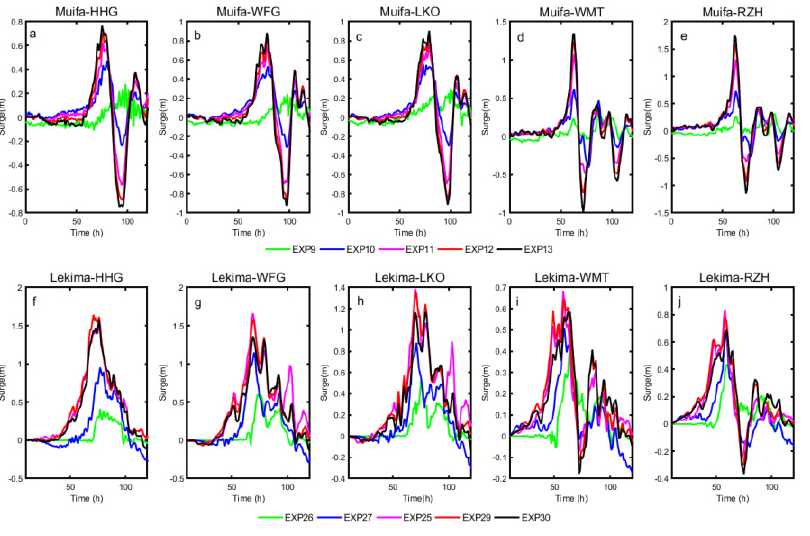
Figure 14. Storm surge associated with the RMW over time at ( a ) HHG, ( b ) WFG, ( c ) LKO, ( d ) WMT, and ( e ) RZH for Typhoon Muifa and ( f ) HHG, ( g ) WFG, ( h ) LKO, ( i ) WMT, and ( j ) RZH for Typhoon Lekima.